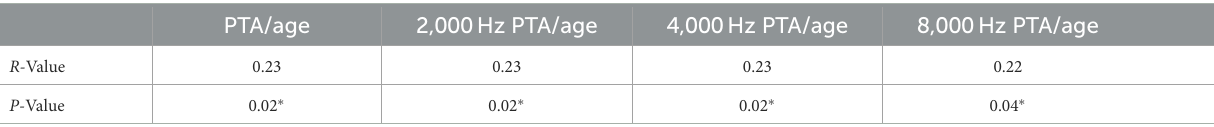
TABLE 6 Relationship between age and PTA at different